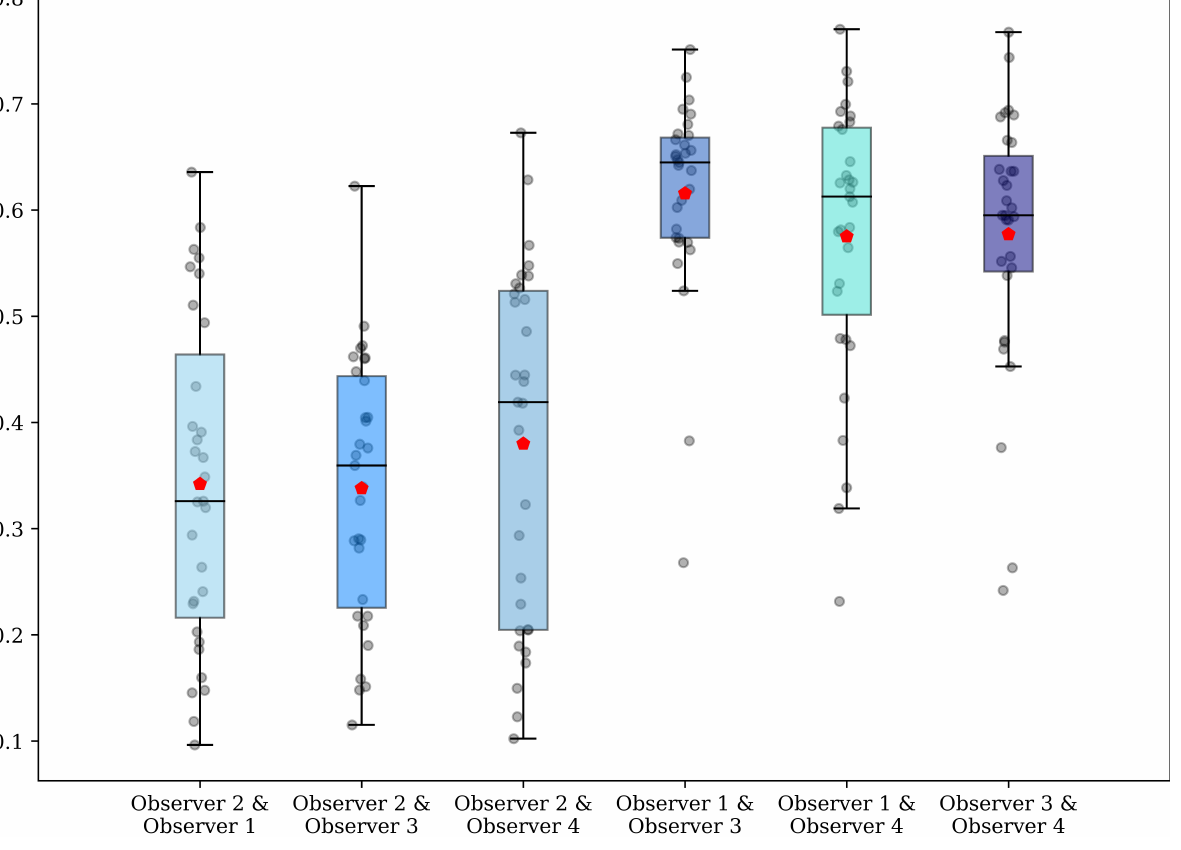
Figure A1. Two-by-two Dice scores between the four observers. The red marker shows the mean